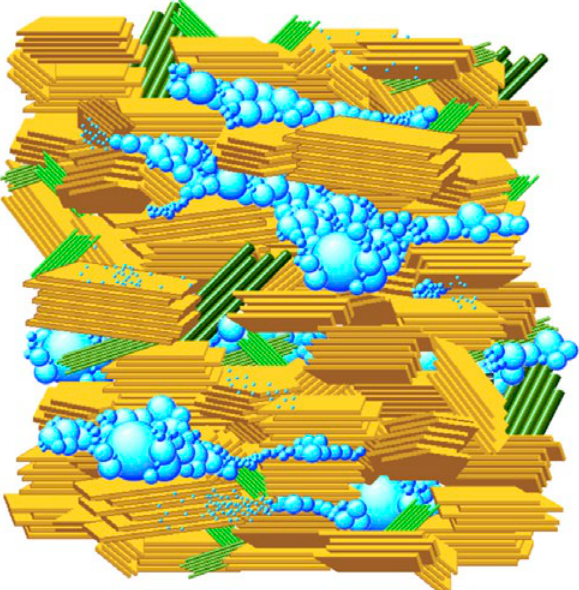
Figure 13. Liquefaction or shear by pasty flow of the sediment allows some ‘close packing’ of silica particles into micro-accretions and orientation of the clusters and chains of particles to result in a schistose or “tuffaceous-looking” greenstone texture as in Figure 18 (From Ellistonr 9 , 2017,